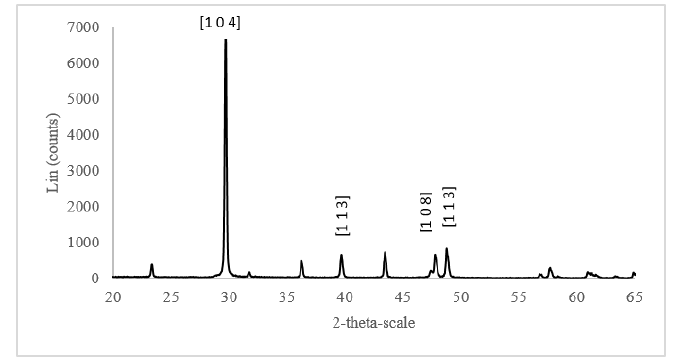
Figure 2. X-ray diffraction (XRD) patterns of eggshell.